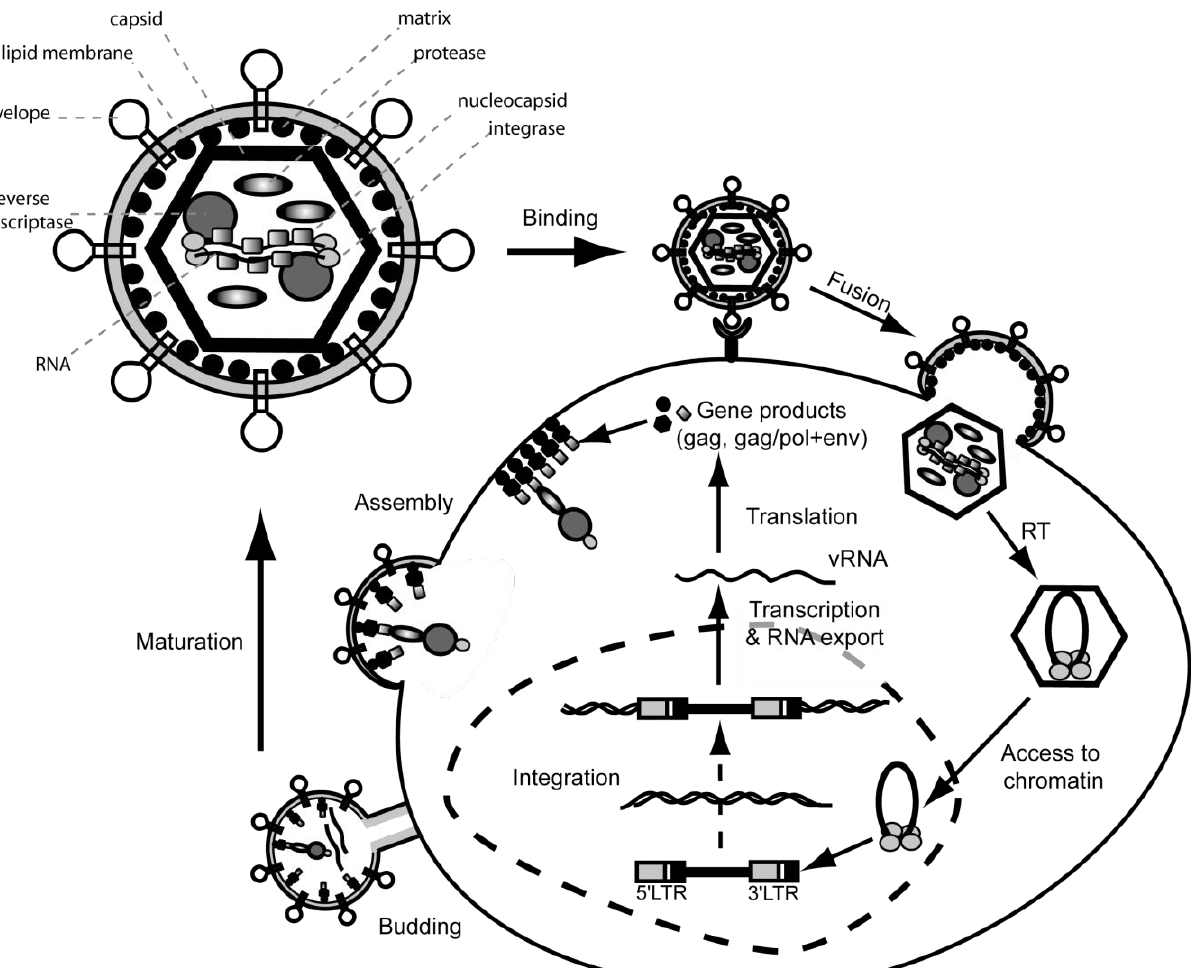
Figure 2. The retroviral life cycle exemplified for MLV. The retroviral particle binds with its envelope to cognate receptors on the target cell surface, which facilitates entry of the virus core into the cell cytoplasm. After reverse transcription, viral DNA is integrated into the host cell chromatin, transcribed, and translated into viral proteins that assemble and bud from the plasma membrane to complete the life cycle with extracellular maturation. RT, reverse transcription; vRNA, viral